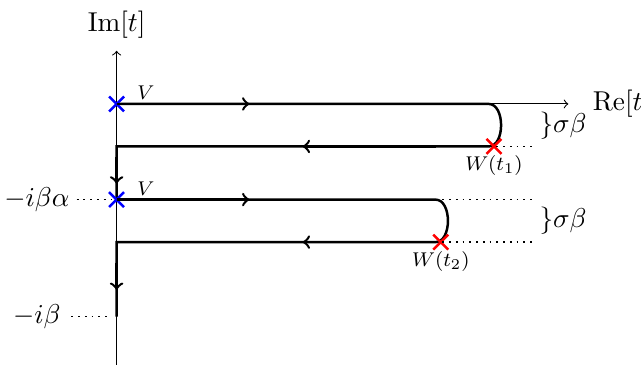
Figure 8 . Extended Schwinger-Keldysh contour corresponding to the two-parameter